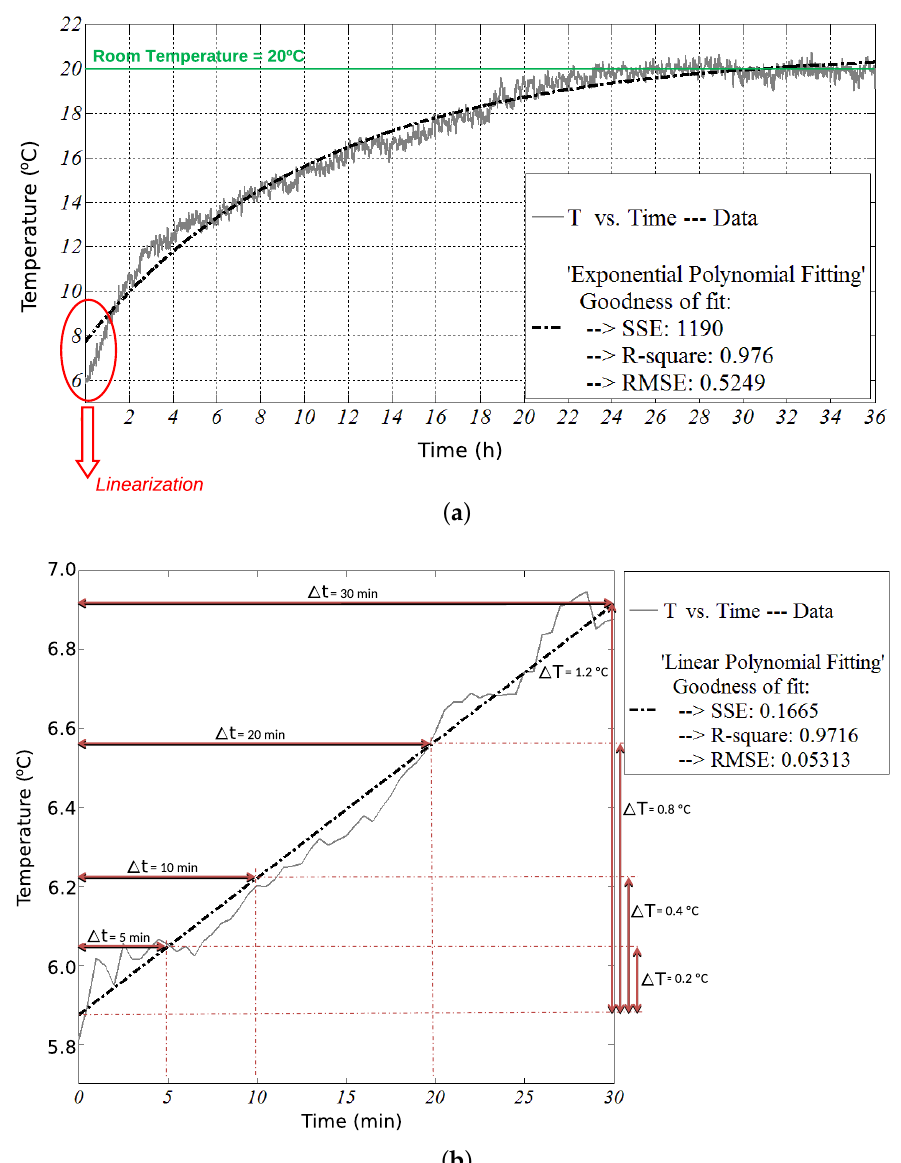
Figure 9. Setting of the maximum allowed disconnection time period ( t maxOFF ). ( a ) Temperature profile in a 36-h disconnection time interval; ( b ) linearization: ∆ T compared to t maxOFF